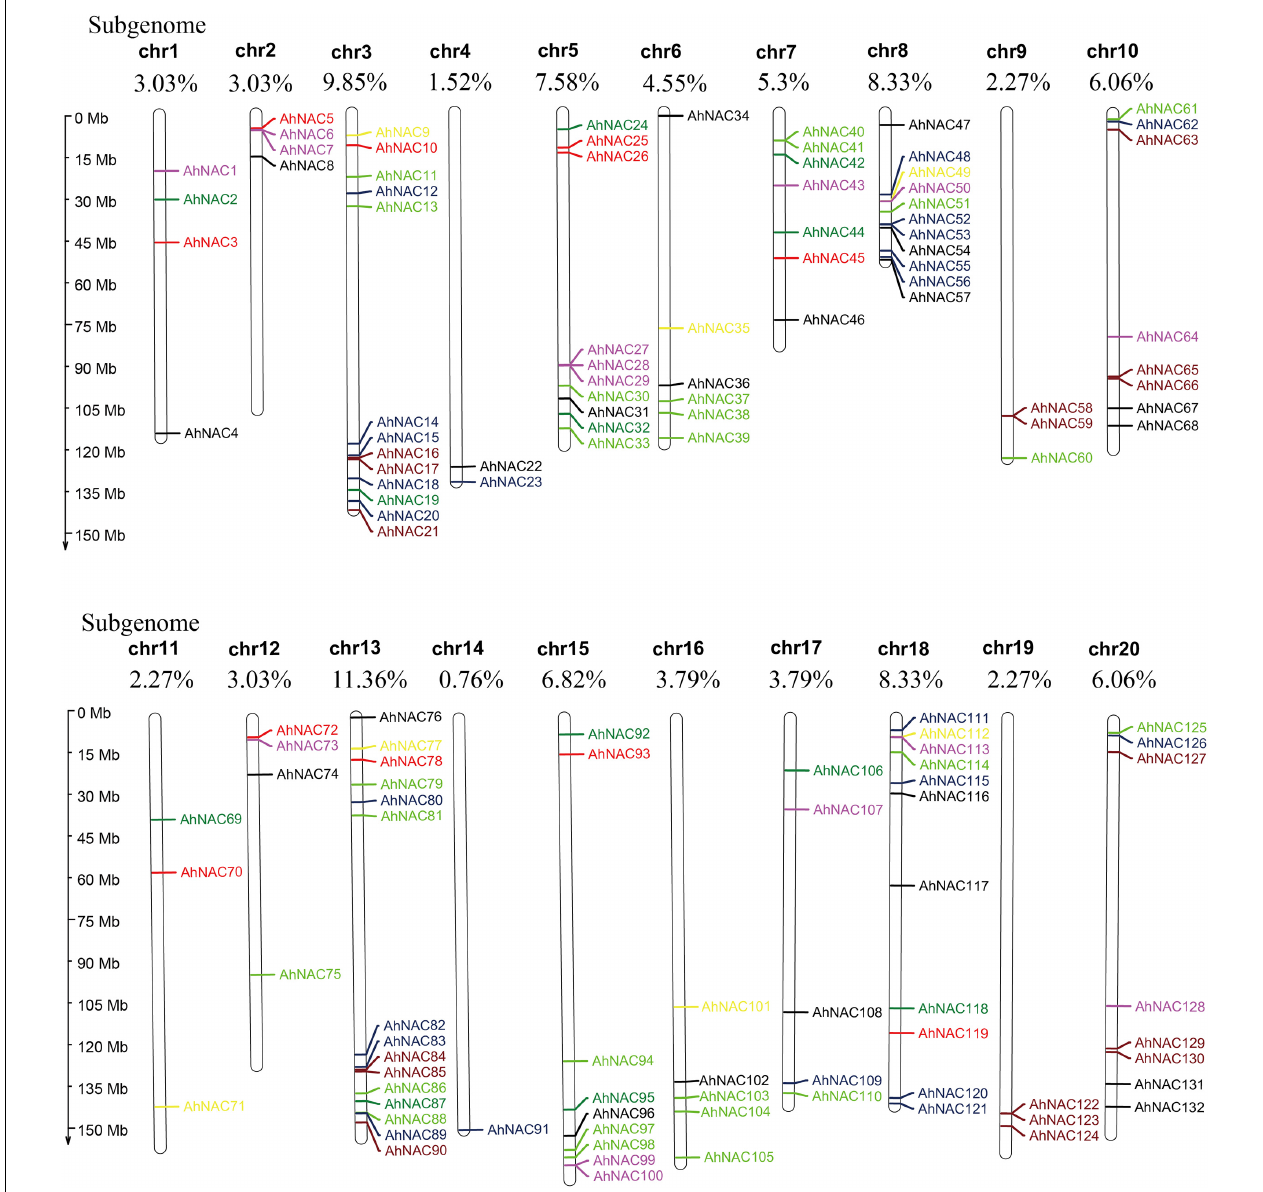
FIGURE 2 | Chromosomal physical map showing the uneven distribution of AhNAC genes on each chromosome. Different colors indicate the different subgroups. The chromosome length is shown to the left of the map, and the serial numbers of chromosomes (chr1–chr20) and the distribution frequencies are shown on the top of each chromosome. Black represents group I, red represents group II, green represents group III, blue–black represents group IV, yellow represents group V, purple represents group VI, light green represents group VII, and brown represents group